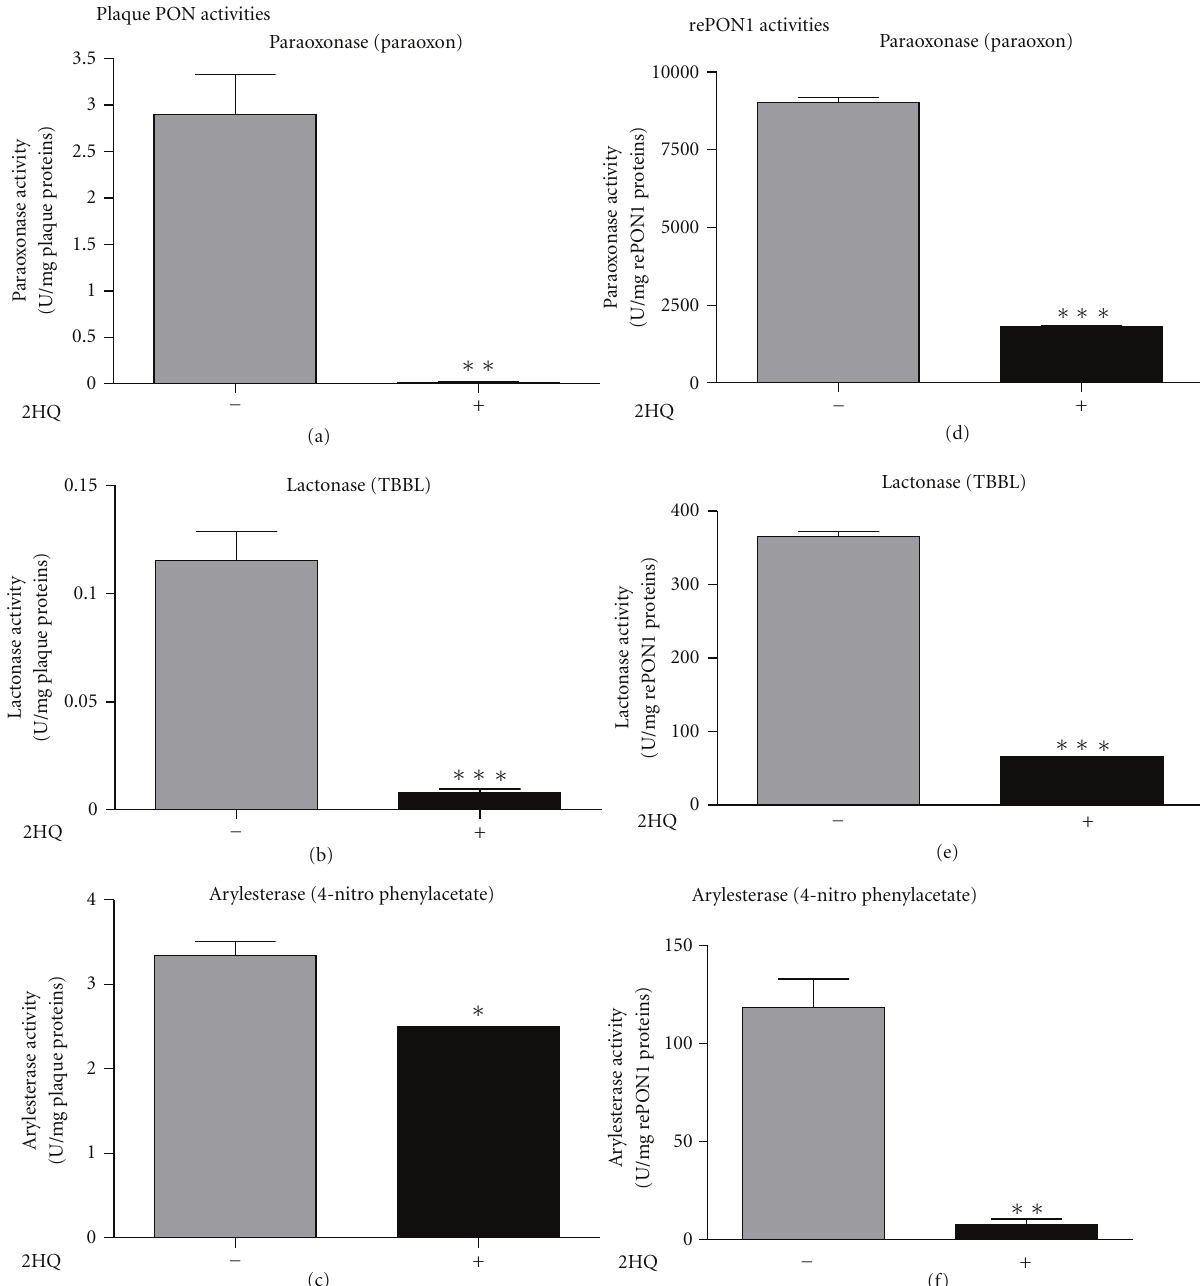
Figure 1: Hydrolytic activities of paraoxonases (PONs) in human carotid plaque homogenate and of recombinant PON1 (rePON1). (a): Homogenate paraoxonase (paraoxon), (b): lactonase (TBBL), and (c): arylesterase (4-nitrophenyl acetate) activities; (d): rePON1 paraoxonase, (e): lactonase, and (f): arylesterase activities, with or without 2-hydroxyquinoline (2HQ).